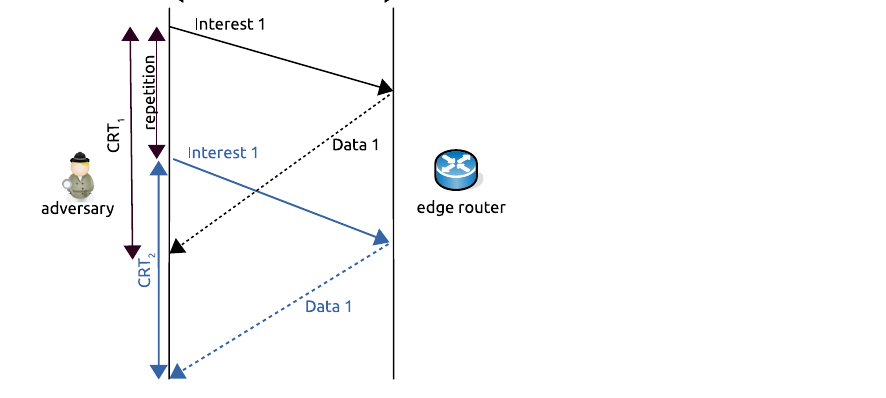
Figure 7. CRT measurements using one repetition of the same packet (Adapted from